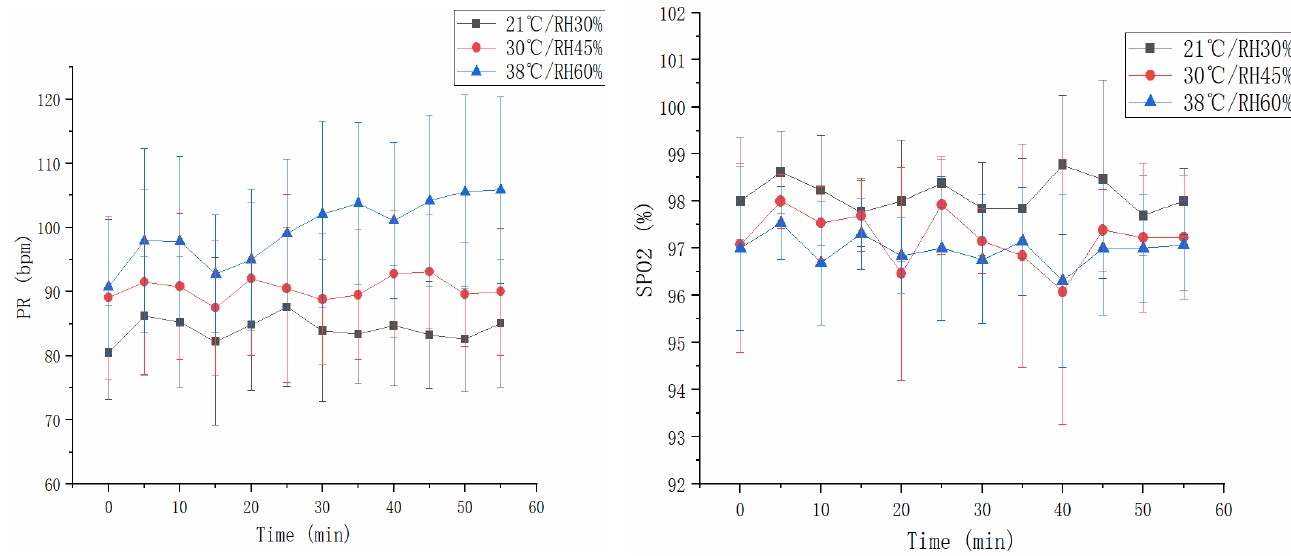
Figure 8. Pulse rate and SpO2 changes under different conditions.